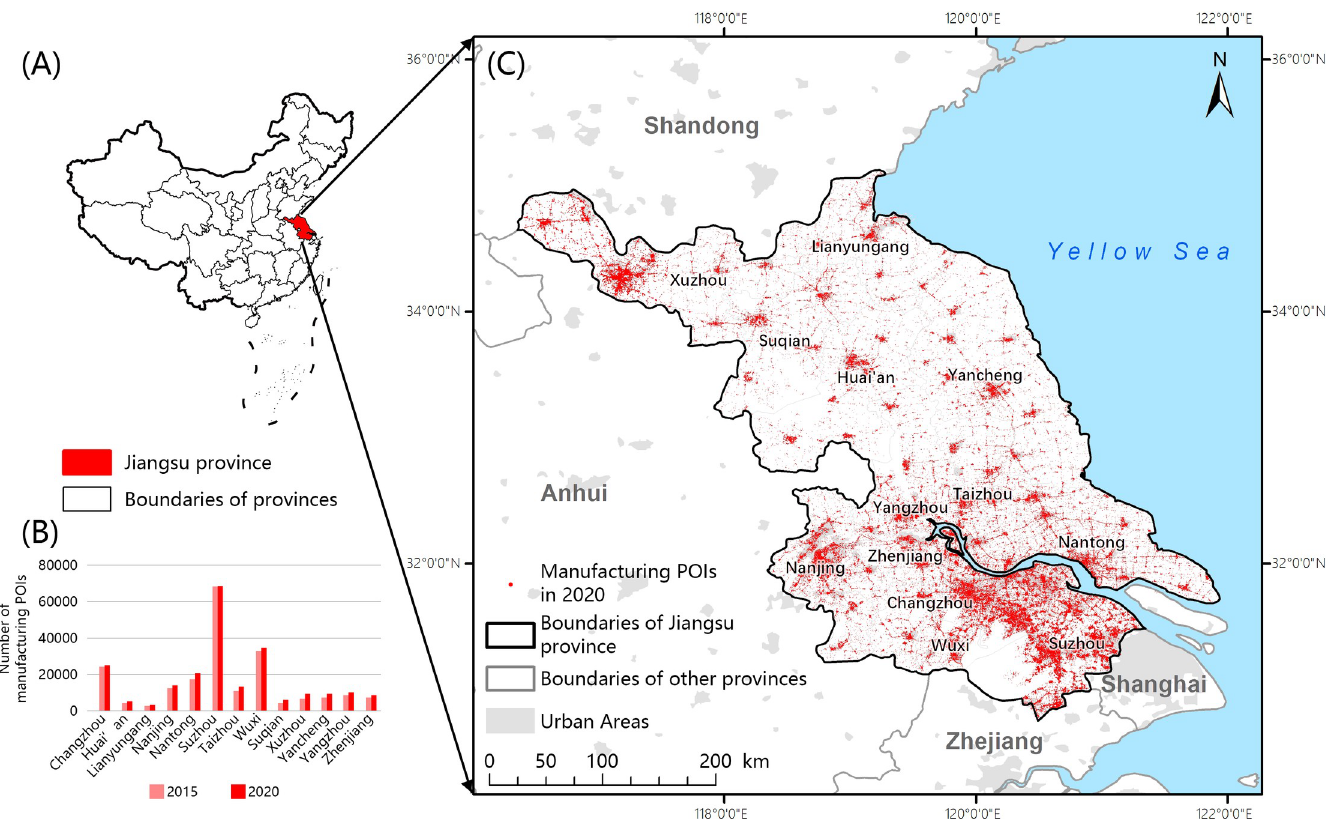
Fig 1. Distribution of manufacturing POIs in Jiangsu province in 2020. (A) The position of Jiangsu province in China. (B) Number of manufacturing POIs in cities of Jiangsu province. (C) Distribution of manufacturing POIs in Jiangsu province. The maps were generated by ArcGIS 10.5 and were for illustrative purposes only.